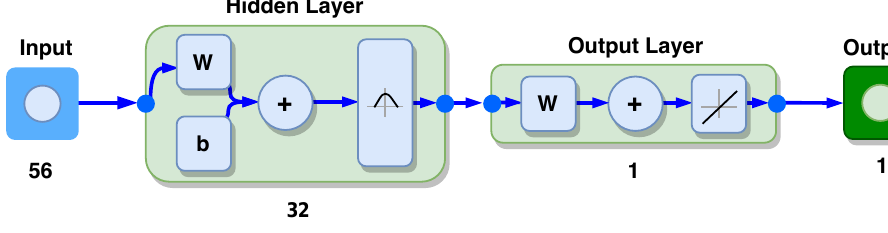
Figure 14. Structural diagram of the Generalised Regression Neural Network (GRNN). The network had 56 input and 32 hidden layers, where the normal distribution function was used as a probability density function. It has one output layer with a linear